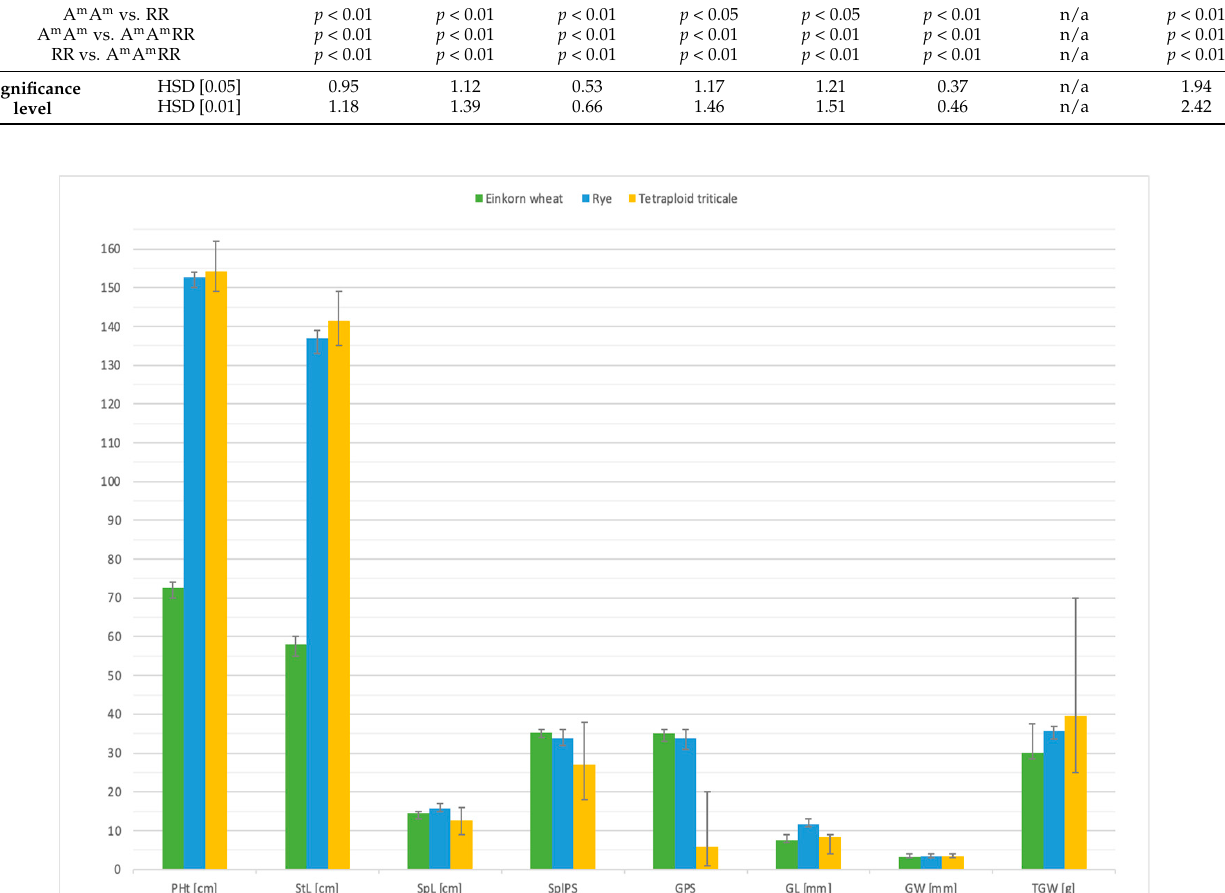
Figure 6. Graphical comparison of the mean and range scores for the following 8 yield ‐ related traits investigated among Triticum monococcum (PI 191383), Secale cereale (Dankowskie Hadron) and tetraploid triticale (amphiploids—S 4 generation): plant height (PHt), stem length (StL), spike length (SpL), number of spikelets per spike (SplPS), number of grains per spike (GPS), grain length (GL), grain width (GW) and thousand ‐ grain weight (TGW).